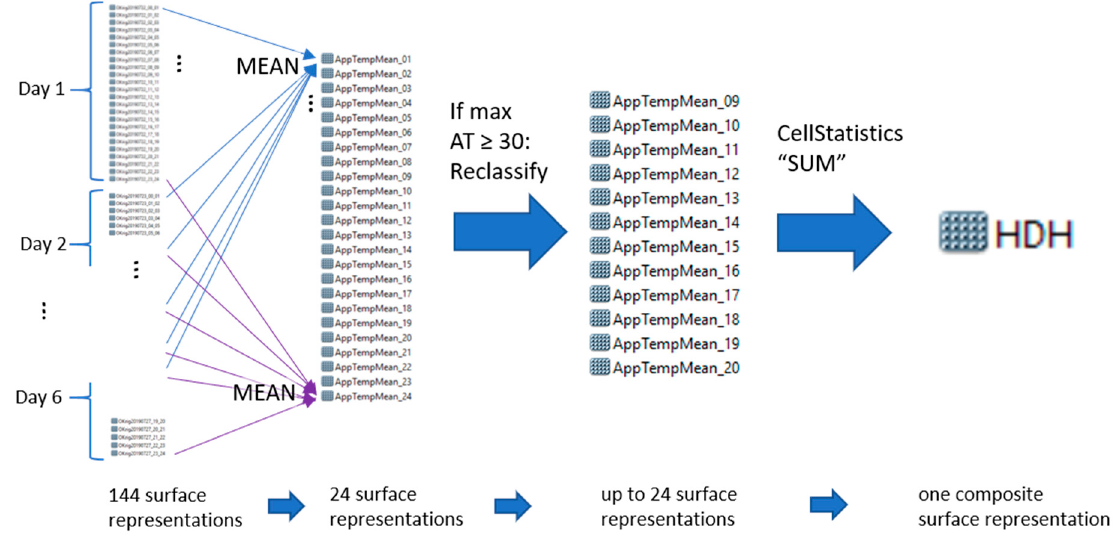
Figure 3. Workflow for production of composite raster surface representing humidex degree hours (HDH). We used the percentage of the population being 65 years or older to represent a vulnerable group particularly exposed to heat. Demographic data are available at the neighbourhood level, which is the lowest enumerative unit used by Statistics Netherlands (Centraal Bureau voor de Statistiek, CBS). We used the data that were collected for 2018. There are 302 neighbourhoods that are entirely or partly within our study area. The percentage of elderly population (65 years or older) ranges from 2 to 82% with a mean at 18.7% and standard deviation at 9.8%. Using the neighbourhood level as data containers, we used zonal statistics and calculated a mean value for HDH for each of the 302 units. That allowed us to identify the neighbourhood areas that has both high HDH values and had a high percentage of elderly in the